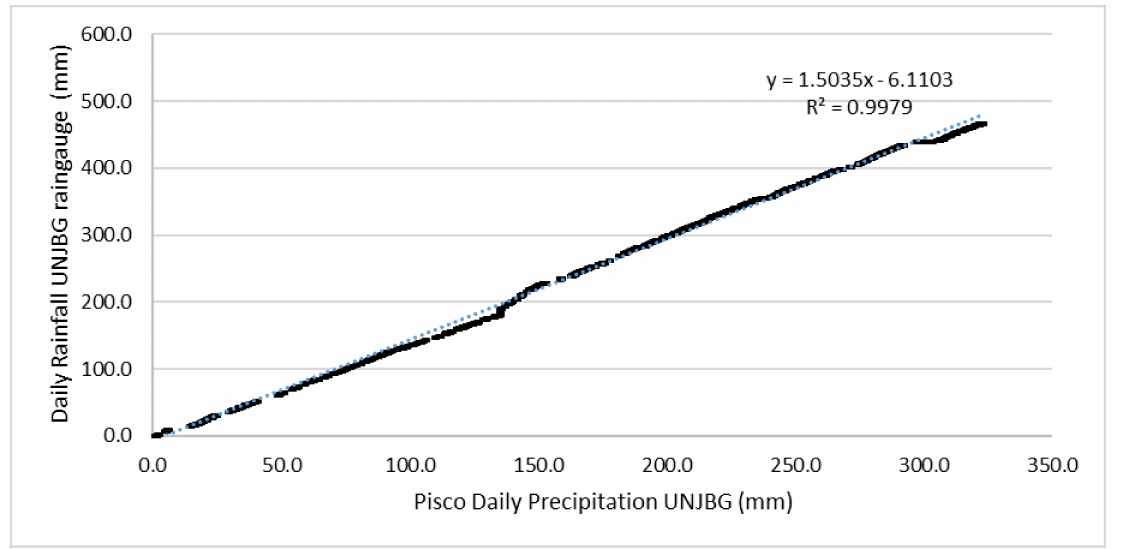
Figure 4. Comparison double-mass between the precipitation data of the PISCO product in JORGE BASADRE rain gauge and the rainfall of the JORGE BASADRE rain gauge, during 7780 days (1 January 1993–21 April